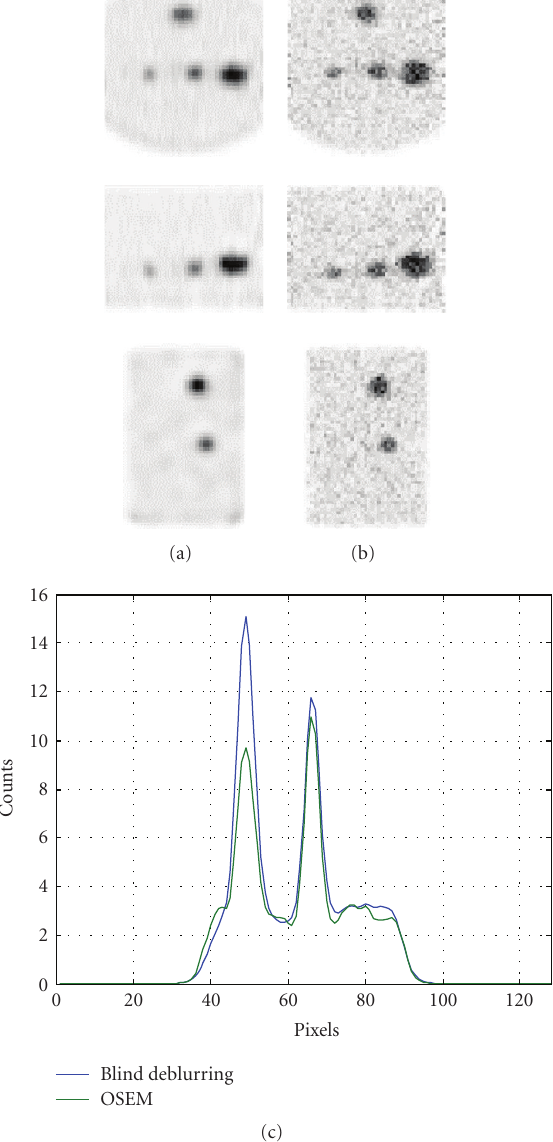
Figure 5: Water phantom reconstruction. From top to bottom are the coronal, sagittal, and transverse